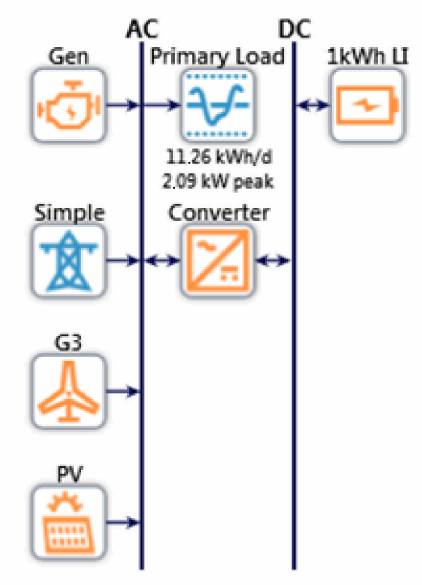
Figure 5. Diagram of the module for obtaining energy from natural sources for the Lubuskie Voivodeship. Source: own study using Homer Grid